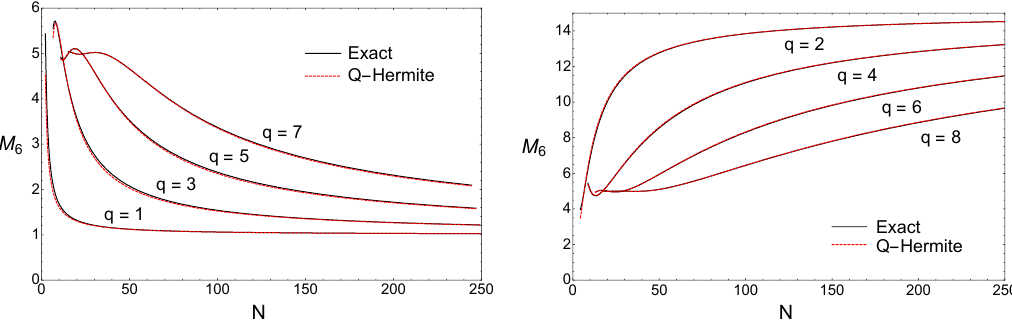
Figure 5 . The N -dependence of the sixth moment of the eigenvalue density of the SYK model for q = 1 ; 3 ; 5 ; 7 (left) and q = 2 ; 4 ; 5 ; 8 (right). We compare the exact result (solid curve) to the Q-Hermite result (dashed).